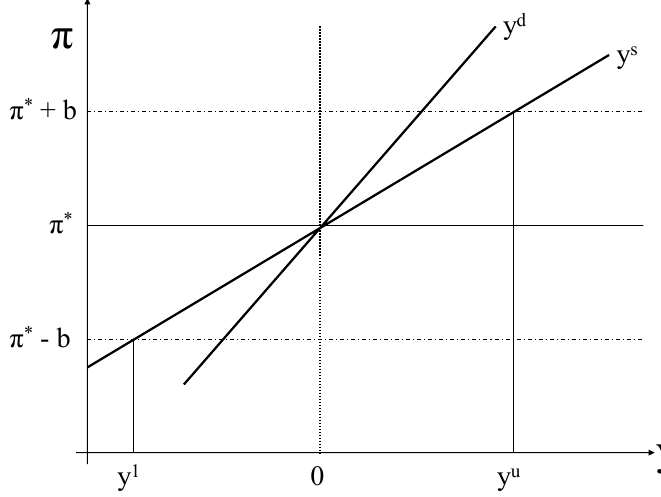
FIGURE 1: The Optimal Band